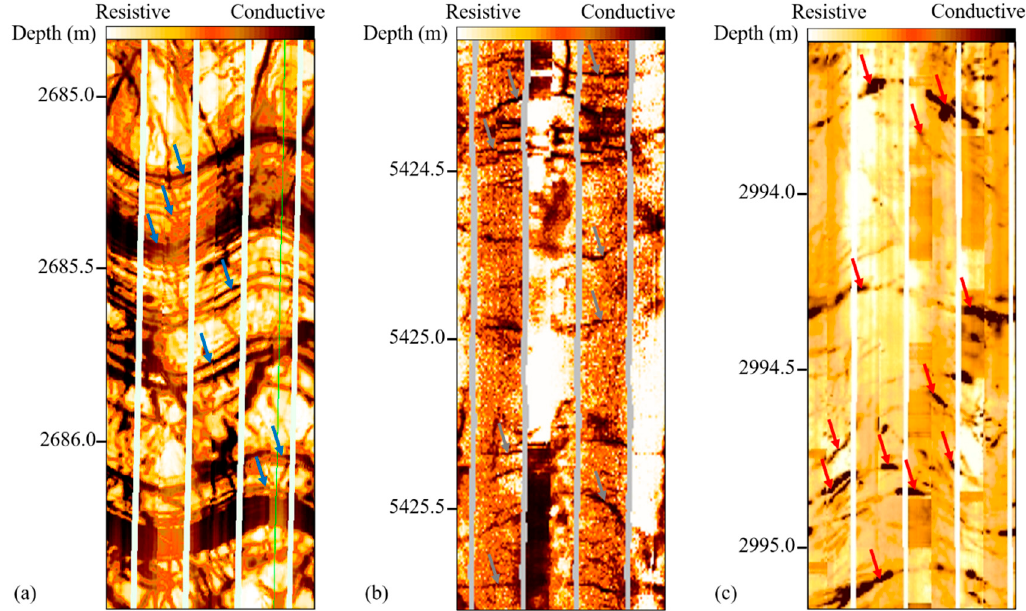
Figure 10. Fractures in borehole image logs. ( a ) Bed-parallel fractures in Well R15. ( b ) Stylolites in Well R1. ( c ) Dissolution fractures in Well R16. The arrows mark the identified fractures.